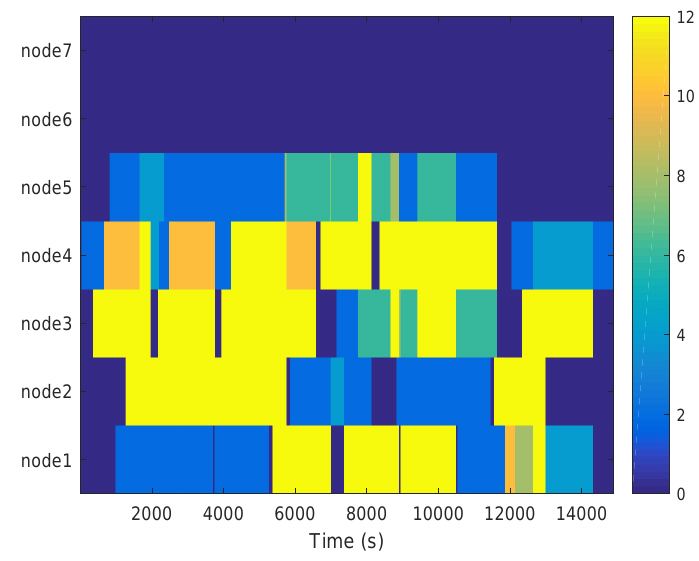
Figure 8. Overall system load for Scenario A using a shared node assignment policy without CLARISSE, thus interferences are not avoided.